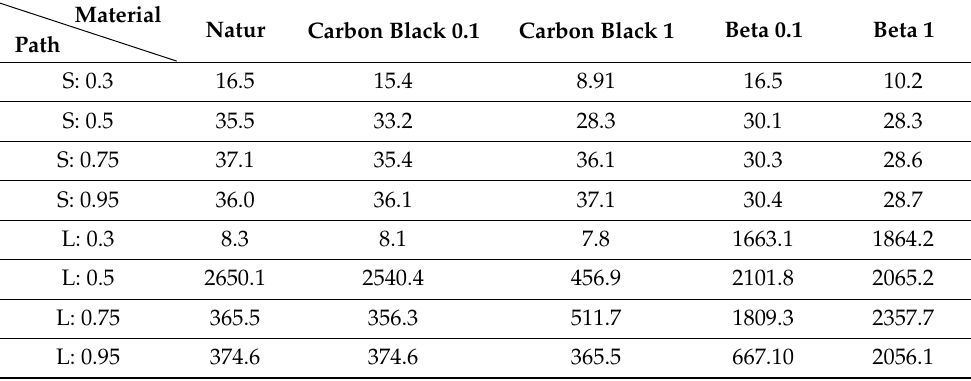
Figure 10. Short-term tensile strength of the welded PP samples for different dimensionless joining paths. Table 3. Mean value of short- and long-term tensile strength of the welded PP samples for different dimensionless joining paths (unit: MPa, S, and L indicate short- and long-term tensile strength re- spectively).